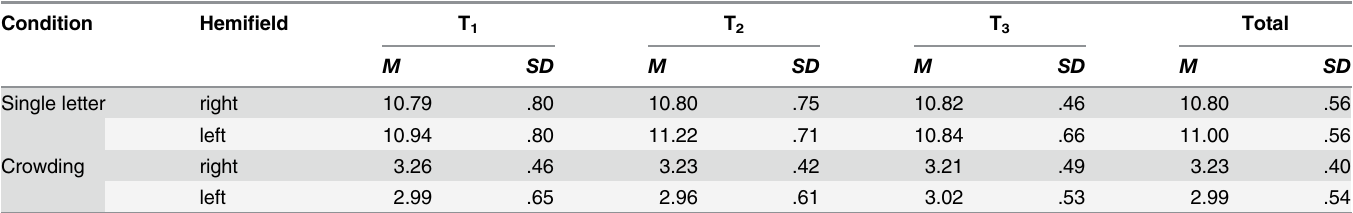
Table 1. Mean threshold eccentricities (in degrees of visual angle) for the single letter identi fi cation and crowding conditions, hemi fi elds, and test repetitions (T 1 to T 3